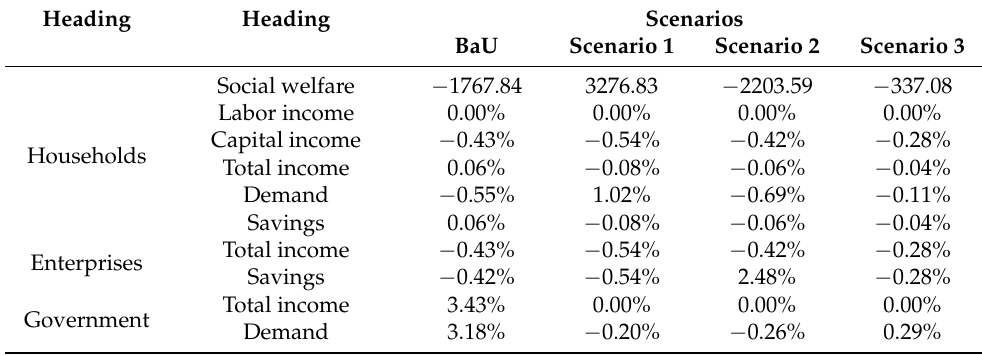
Table 4. Statistics of macroeconomic variables of